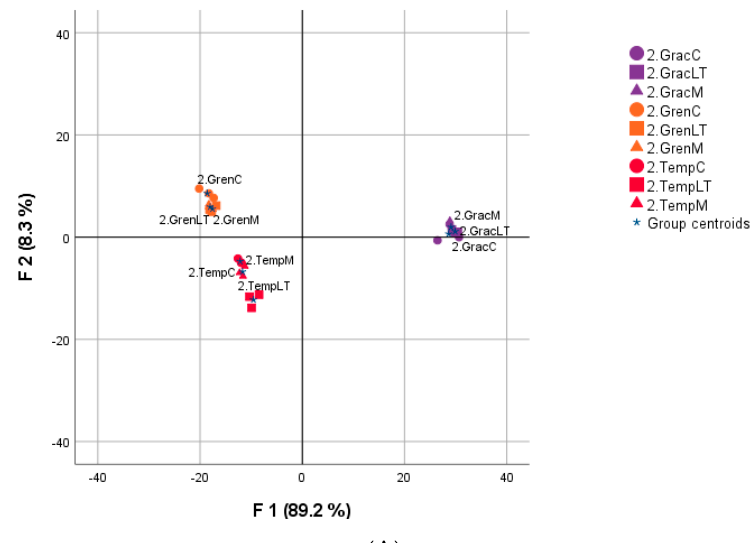
Figure 4. ( A ) Canonical discriminant graph of oenological parameters in control samples (C), samples early inoculated with M. pulcherrima (M) and samples early inoculated with a mix of L. thermotolerans & T. delbrueckii (LT), after alcoholic fermentation (2.) of Tempranillo (Temp), Grenache (Gre) and Graciano (Gra) ( B ) Standardized canonical coefficients of the four main discriminant variables in functions (F1 and F2) for oenological parameters.